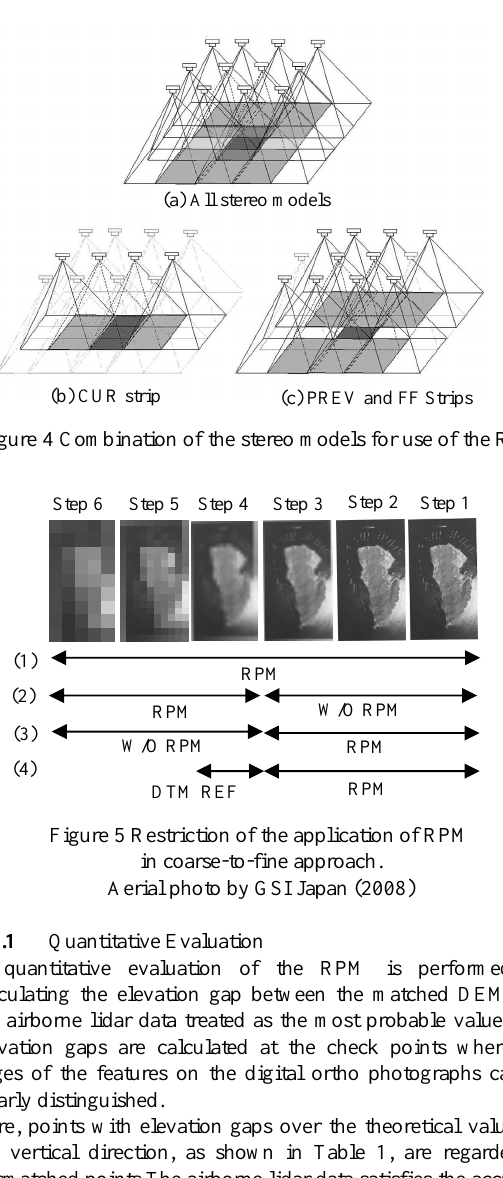
combinations for the